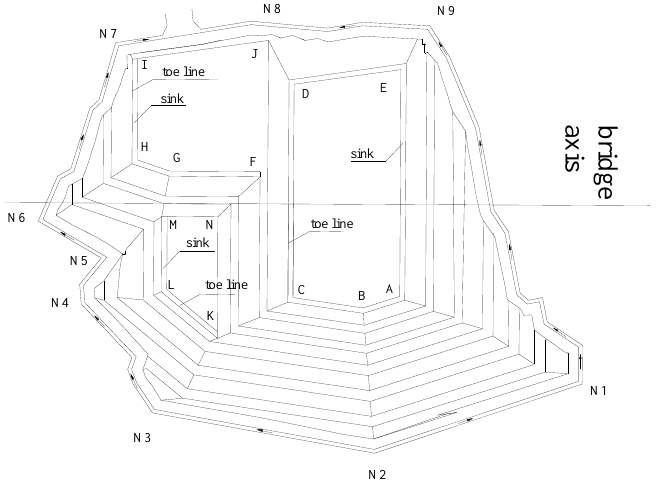
Figure 2. Elevation of suspension bridge.